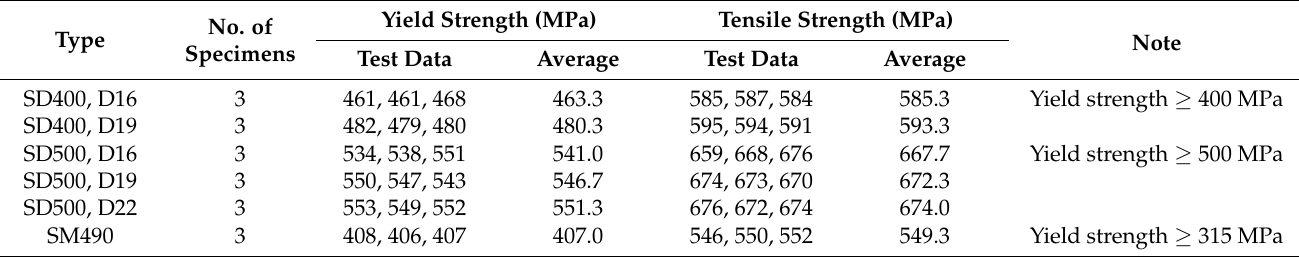
Table 4. Rebar and steel plate tensile strength